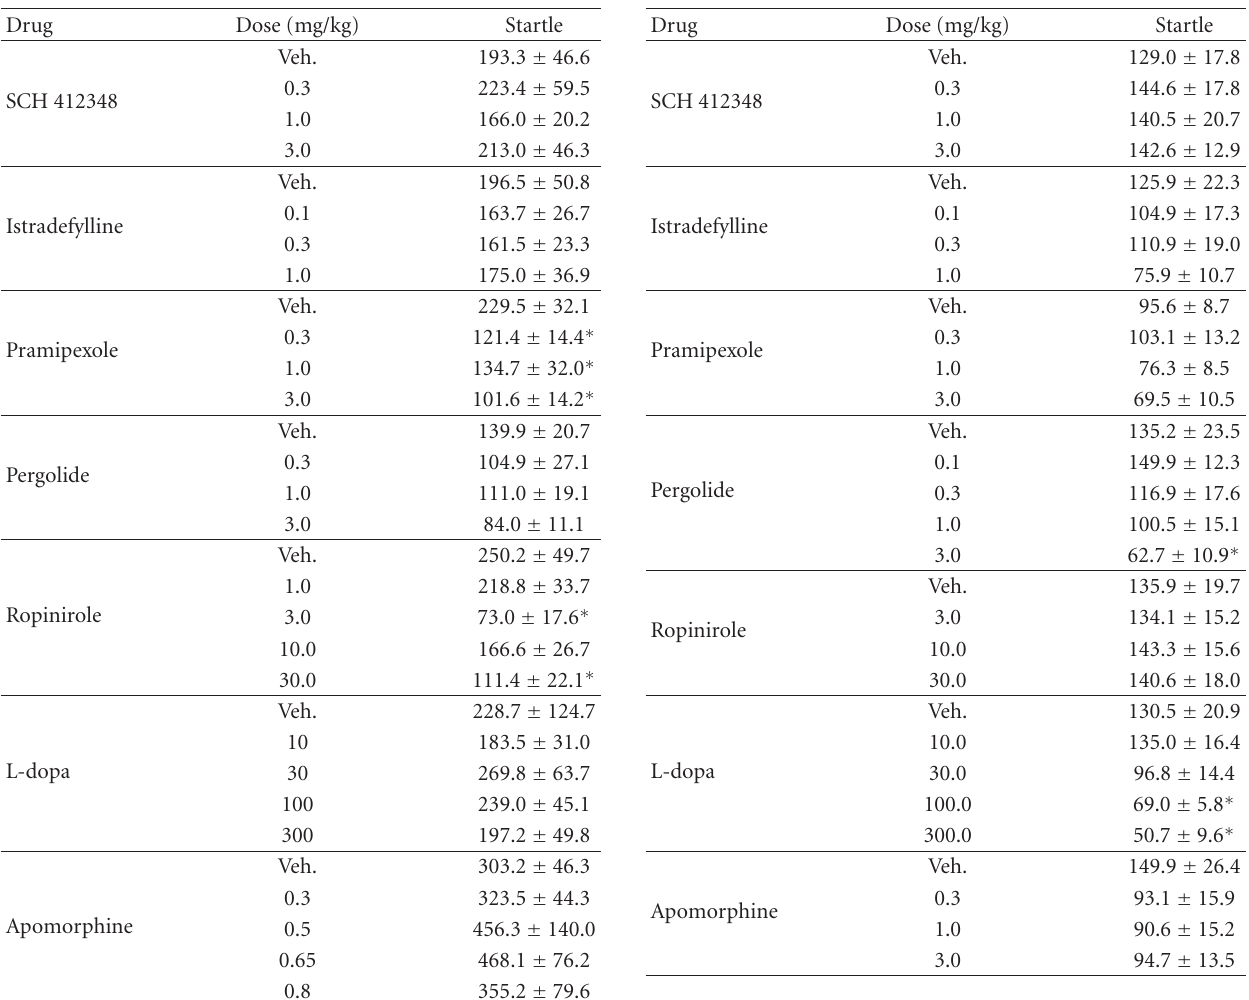
Table 1: Mean startle magnitude ± SEM in rat prepulse inhibition ( ∗ P < 0 . 05 versus vehicle).